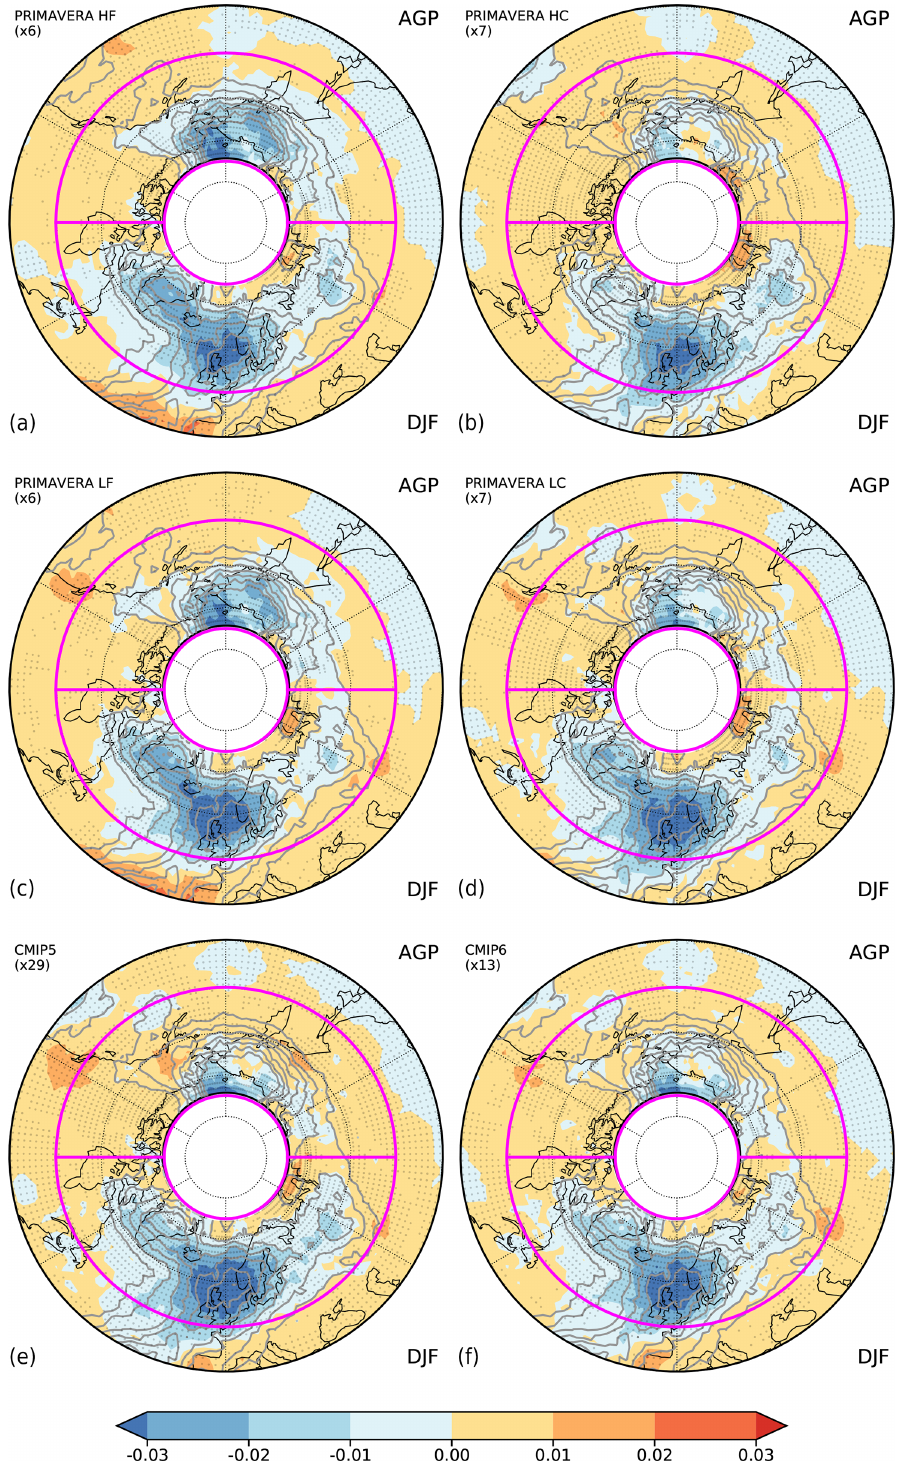
Figure 1. Bias in the frequency of blocked days for the AGP index for boreal winter: (a) high-resolution forced, (b) high-resolution coupled, (c) low-resolution forced, and (d) low-resolution coupled PRIMAVERA simulations and (e) CMIP5 and (f) CMIP6 simulations. Stippling shows agreement on the sign of the bias by at least (a, c) 6 of 6, (b, d) 6 of 7, (e) 19 of 29, and (f) 10 of 13 simulations. Grey contour lines show the reanalysis blocking frequency at contour intervals of 0.01 and starting from 0.01. ATL and PAC evaluation domains are shown by magenta